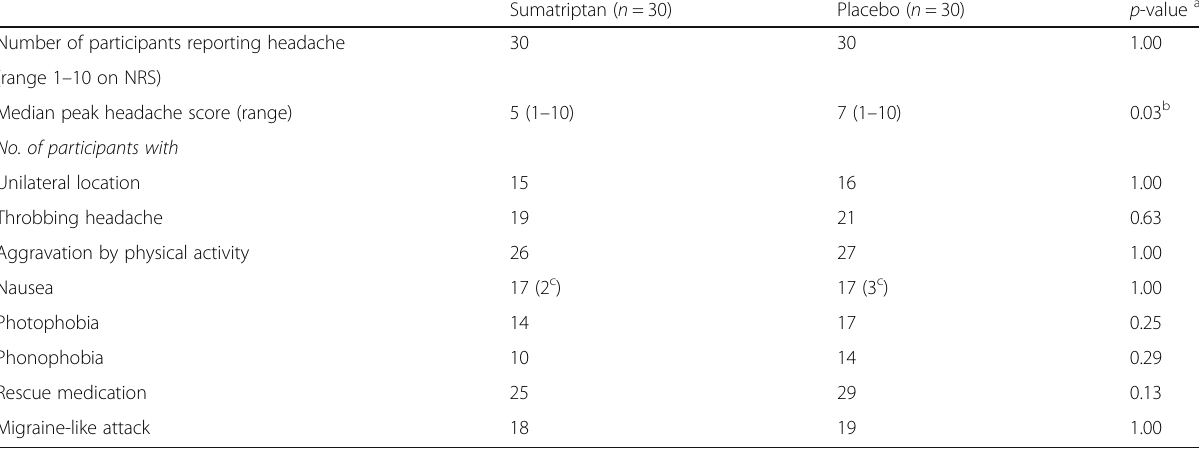
Table 1 Clinical characteristics (our secondary end-point) of headache and associated symptoms after